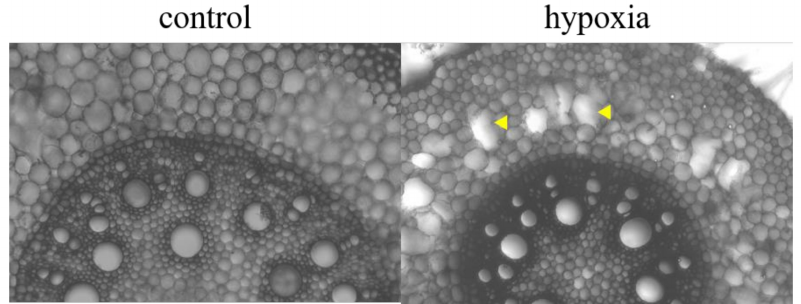
Figure 6. Aerenchyma formation in the mature zone of maize primary root cross-sections. Control and 24 h hypoxia-stressed maize roots were cross-sectioned, by hand, for observation of aerenchyma (indicated with arrows). Images taken with 10x magnification using a Leica DM500 binocular microscope.